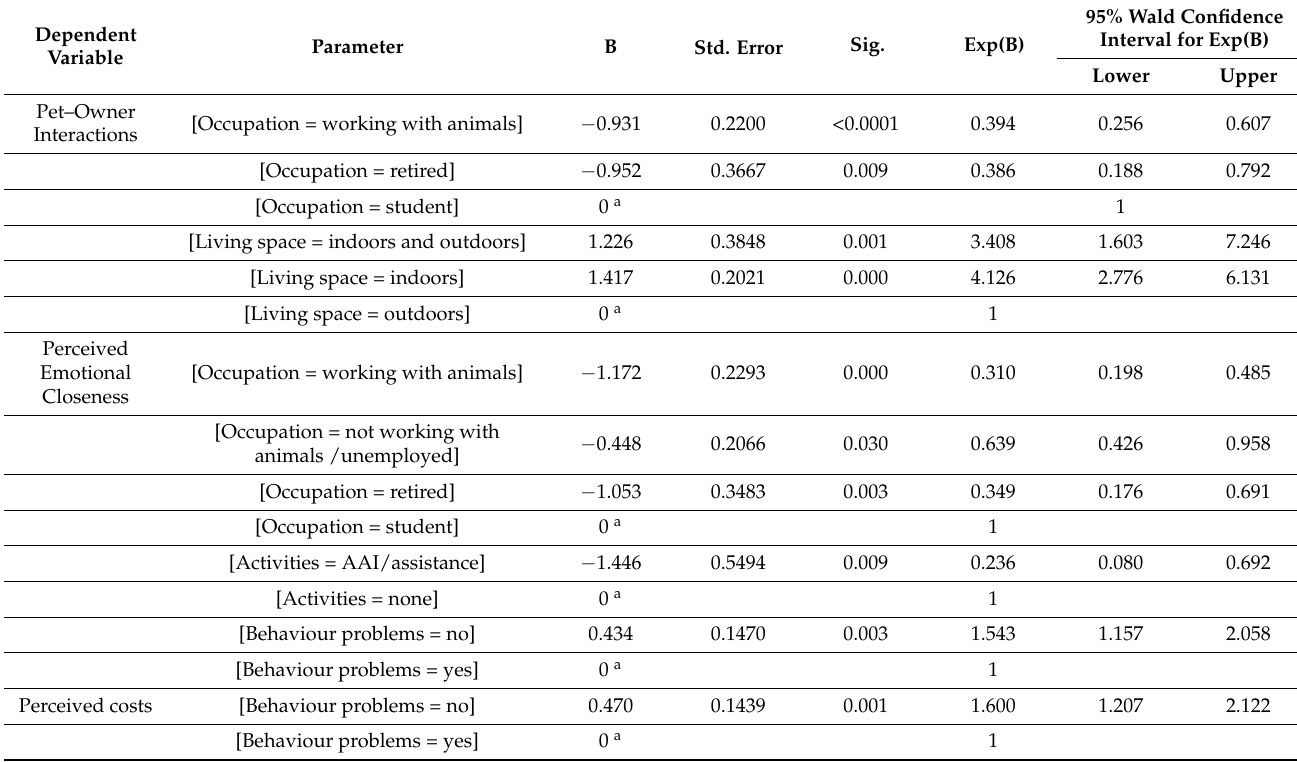
Table 7. Ordinal regressions for the response variables C/DORS Pet–Owner Interactions, Perceived Emotional Closeness and Perceived